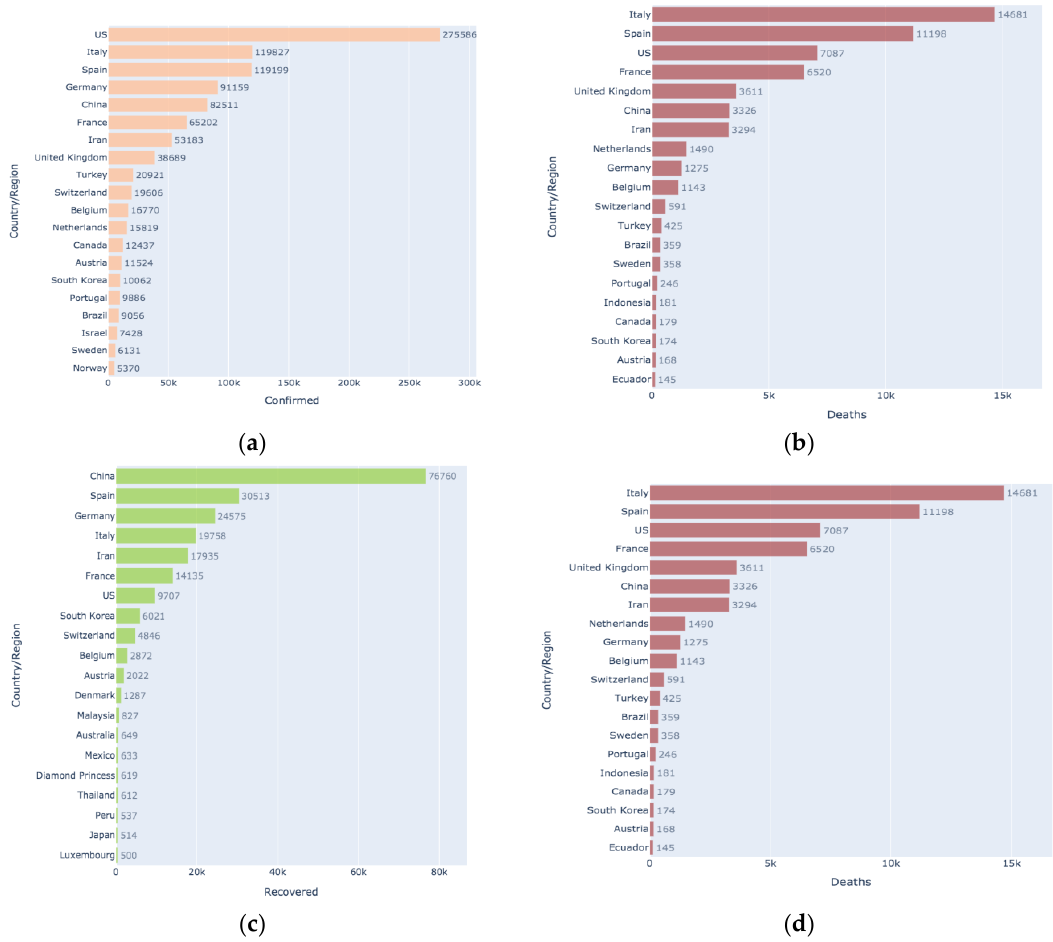
Figure 8. COVID-19 spread across the globe: ( a ) cases confirmed; ( b ) cases that resulted in death; ( c ) cases recovered; and ( d ) cases active globally.